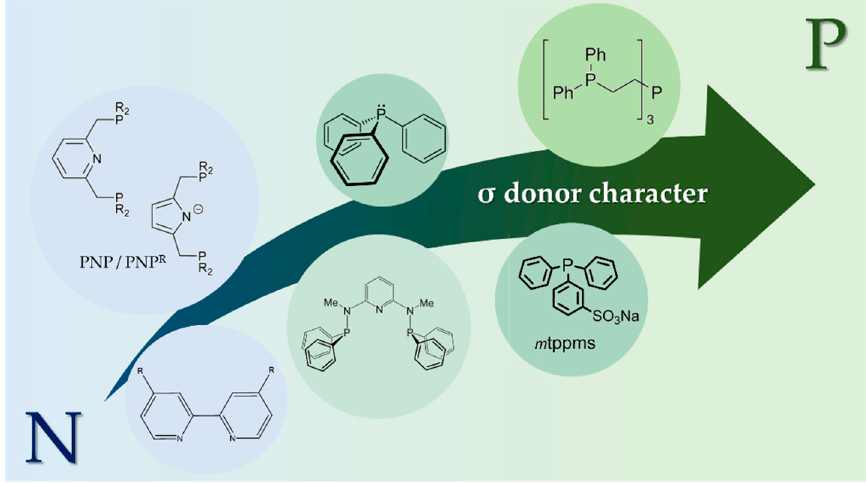
Figure 10. The increasing of σ - donor character proceeding from Nitrogen to Phosphorous